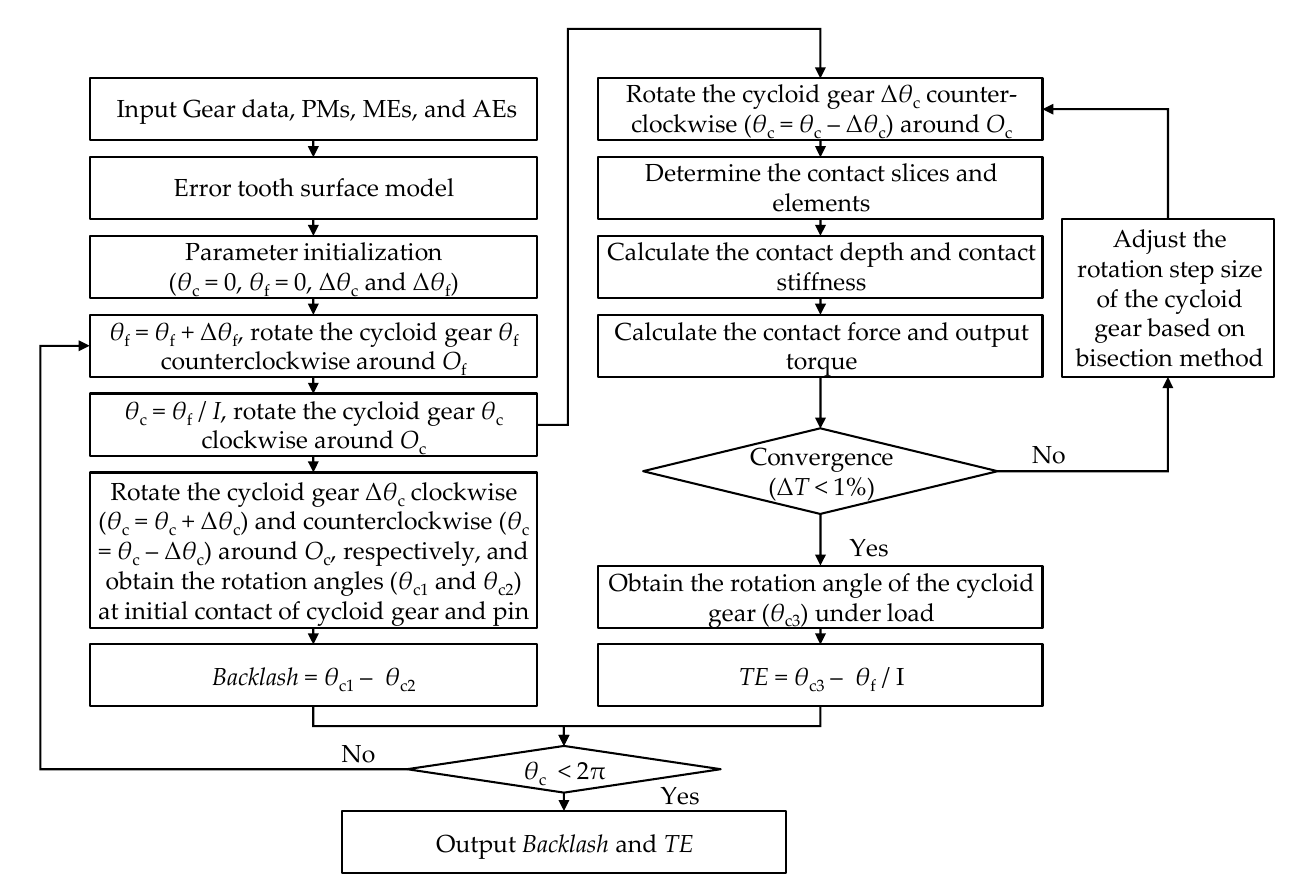
Figure 4. Flow chart of the calculation process of TE and backlash.